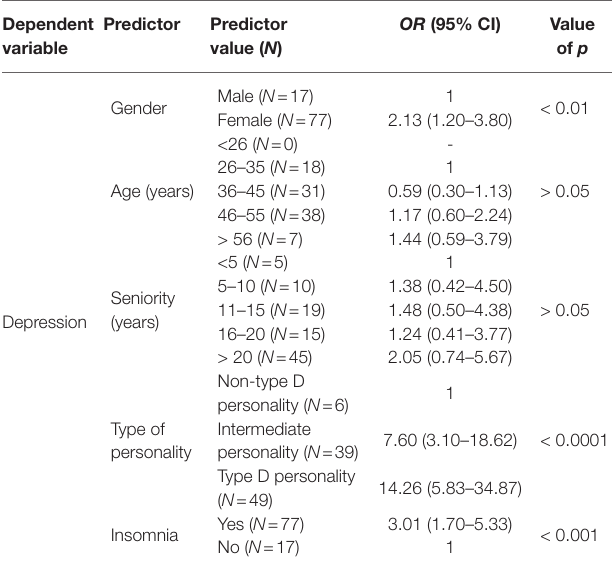
TABLE 7 | Factors determining the occurrence of depression in the group of surveyed teachers.